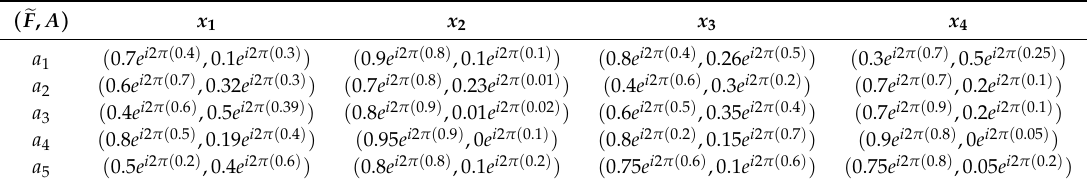
Table 2. CIFSL - G information about the employees